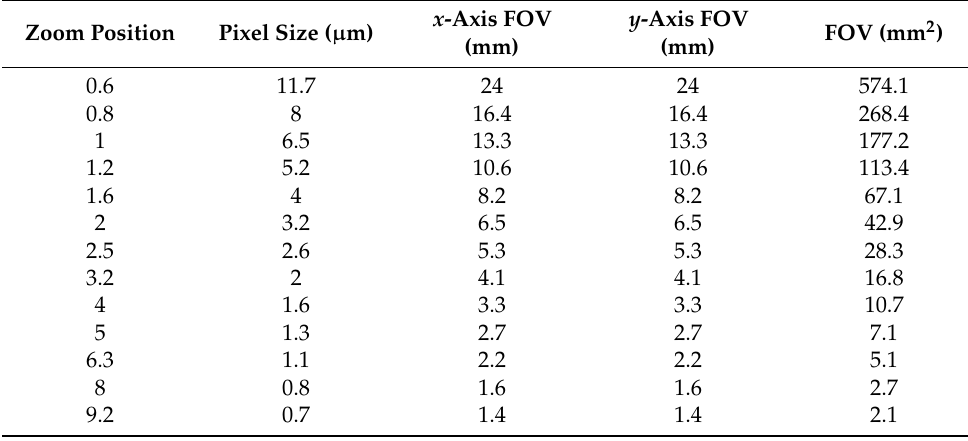
Table 1. Histo3D pixel size and field of view for specific Z16 zoom